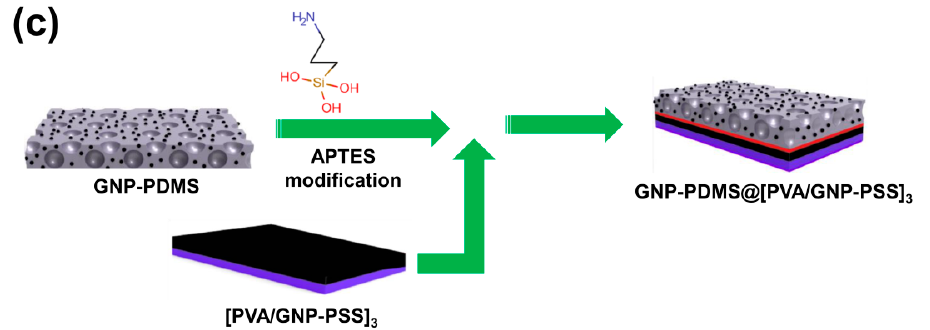
Figure 1. Fabrication procedure of the GNP-PDMS@[PVA/GNP-PSS] 3 TENGs. ( a ) GNP-PDMS preparation process. ( b ) LbL assembly of [PVA/GNP-PSS] 3 multilayers. ( c ) APTES-mediated linkage of GNP-PDMS and [PVA/GNP-PSS] 3 composite films.